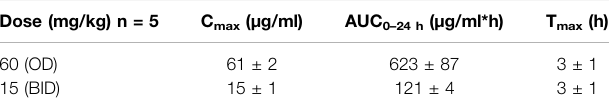
TABLE 2 | Summary of Pharmacokinetic Parameters in Syrian